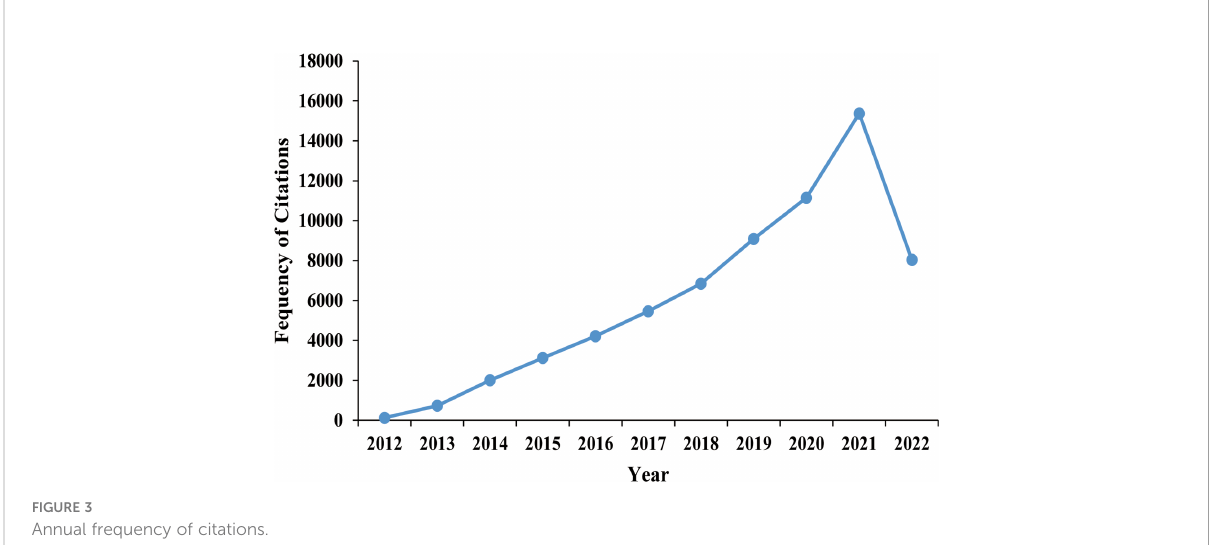
FIGURE 3 Annual frequency of